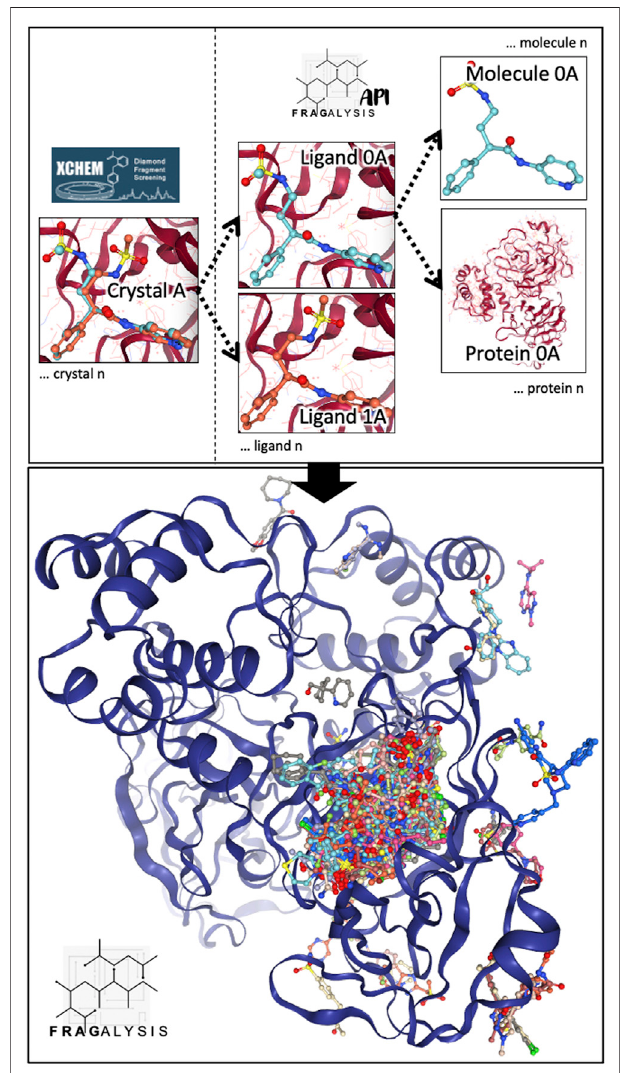
FIGURE 3 | Fragalysis aims to provide immediate access to ligand- protein information without confounding crystallographic artifacts. To achieve this, a given crystal structure (top left — Crystal A) is inspected to fi nd all of the individual ligands. These ligands are then separated into separate bound-stateentities(topright — Ligand0AandLigand1A)usingtheFragalysis API. Ligands are subsequently separated from their respective protein (top- right Ligand 0A and Protein 0A), and presented in Fragalysis as part of an ensemble of all ligands and proteins in the same reference frame (bottom).